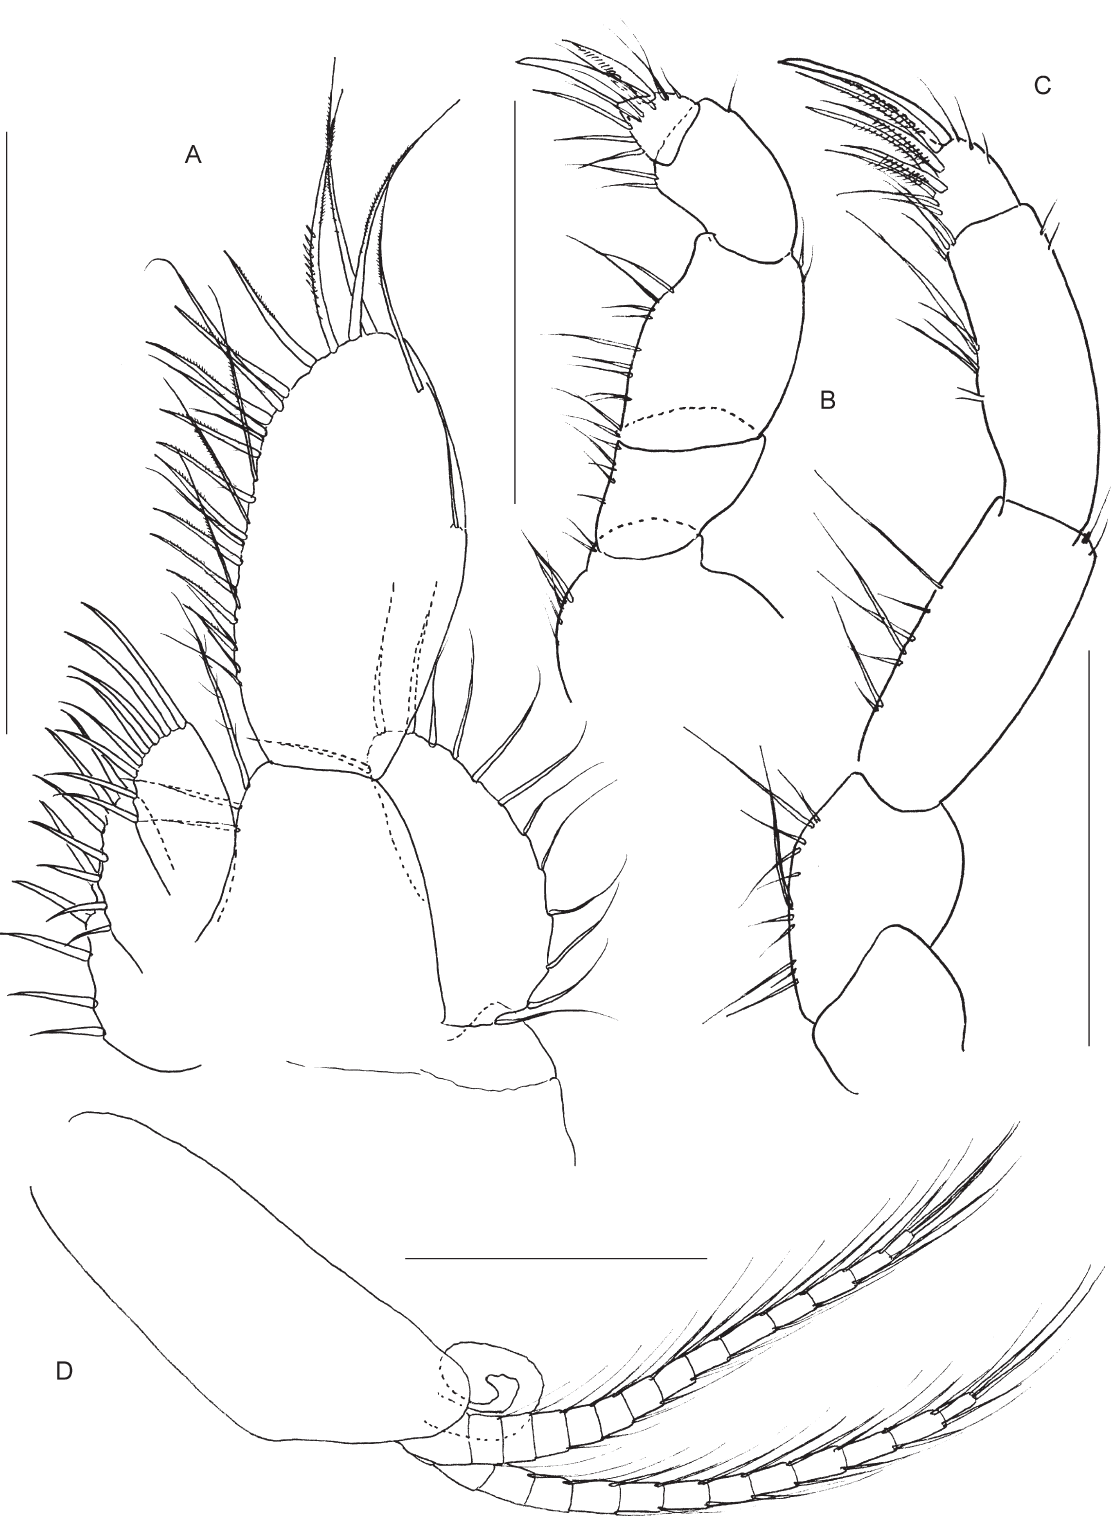
Fig. 5. Siriella bassi sp. nov. Australia, Victoria, Western Bass Strait. A . Maxilla 2, anterior view. B . Endopod of maxilliped 1, posterior view. C . Endopod of maxilliped 2, posterior view. D . Pleopod 4. A –C = holotype, ♀, length 8.5 mm; D = paratype, ♂, length 7.5 mm. Scale bars: 0.25